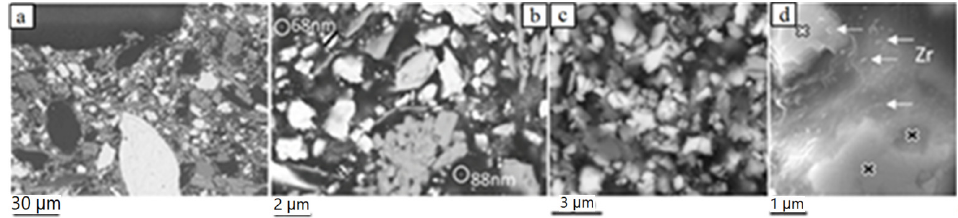
Figure 4. BSE-SEM images of the new brake pad surface showing the spectrum of particle shapes and sizes of the matrix. ( a ) coarse and fine matrix particles; a few ‘large’ particles are observed; ( b , c ) fine and less coarse matrix particles; two ultrafine particles are encircled in ( b ); ( d ) nearly spherical, ~100–150 nm to a few tens of nanometer-large Zr-bearing particles (analyzed particles indicated by arrows); black- and white-filled crosses mark analyzed sites of a Zr- and Ba-S-bearing phase, respectively. The samples are impregnated and polished. Image ( a ) is taken on side view (pad profile), all others on top